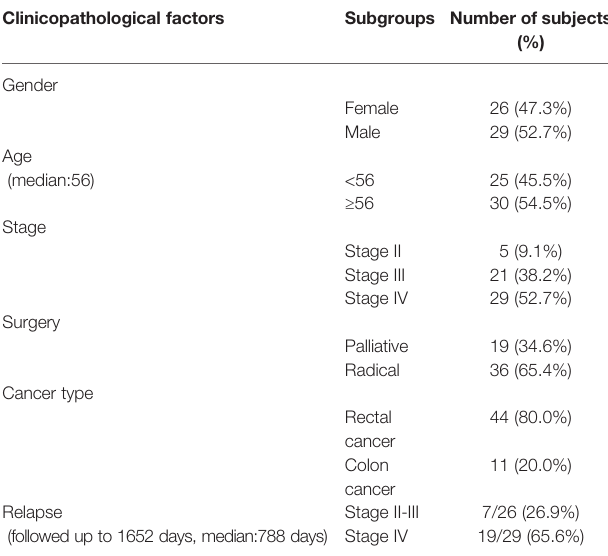
TABLE 1 | The clinicopathological information of all patients recruited in this